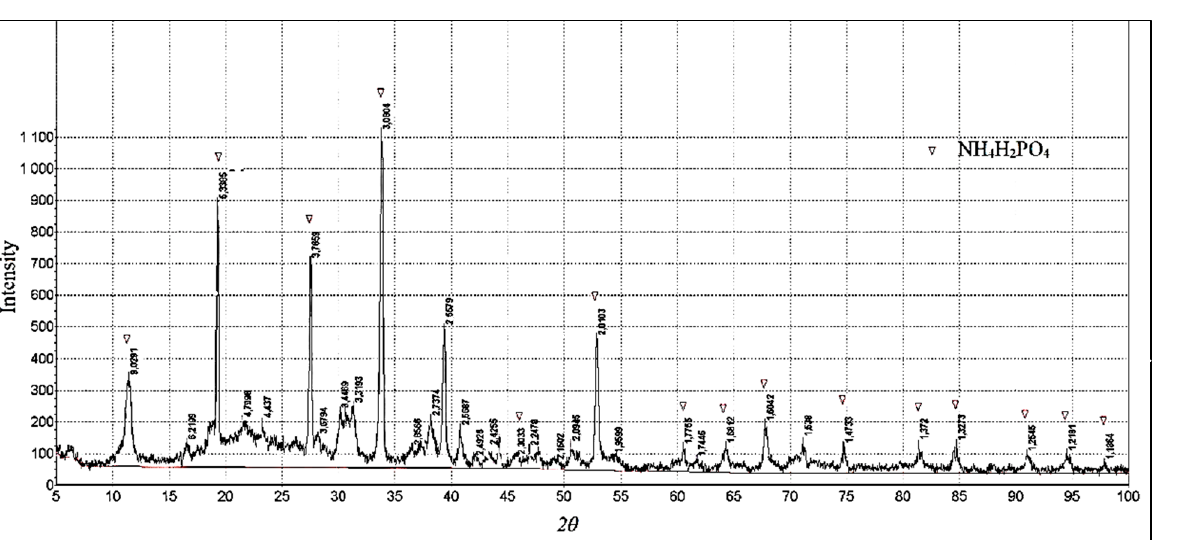
Figure 4. XRD pattern of the product of PH 3 oxidation by aqueous copper–ammonia complexes; labels refer to reflections attributed to monoammonium phosphate—NH 4 H 2 PO 4 (ASTM 1-817).